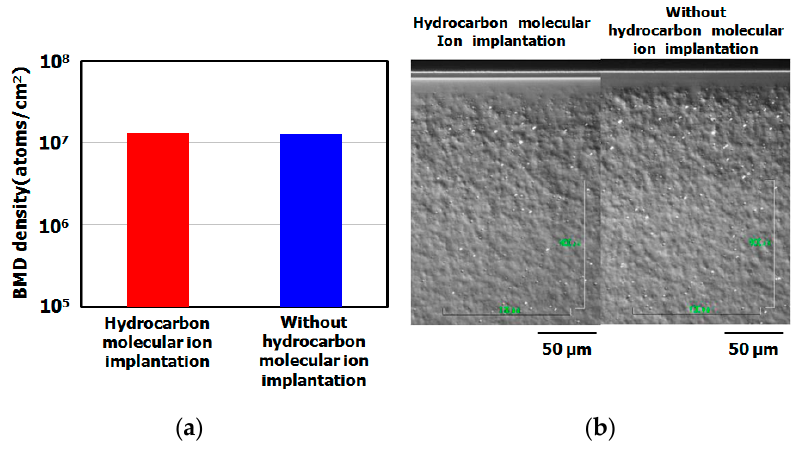
Figure 9. Cross-sectional bulk micro defect (BMD) density determined by optical microscopy observation after CMOS image sensor fabrication process on epitaxial silicon wafers with and without hydrocarbon–molecular–ion implantation. The epitaxial thickness is 7 μ m and hydrocarbon–